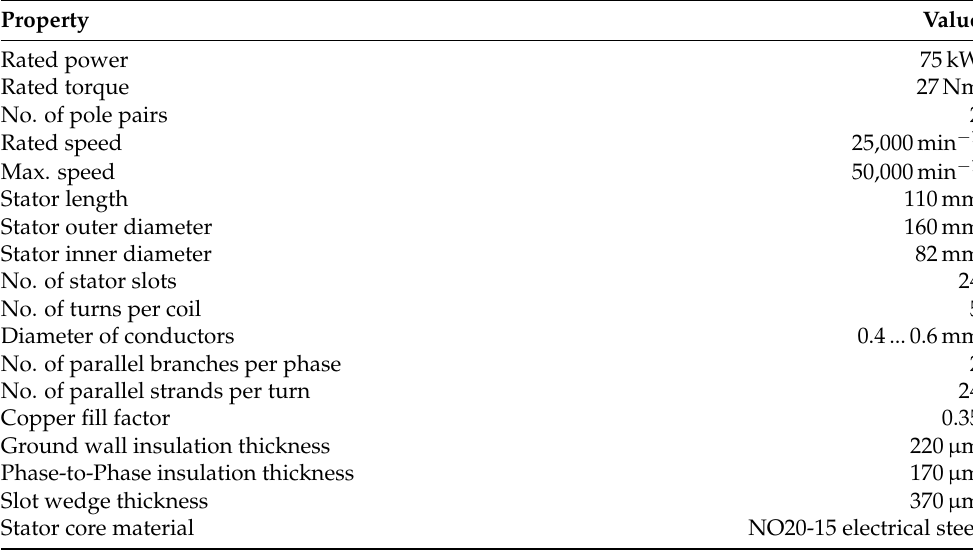
Figure 2. Flowchart of the complete methodology. Table 2. Winding, geometrical, and insulation properties of stator specimen